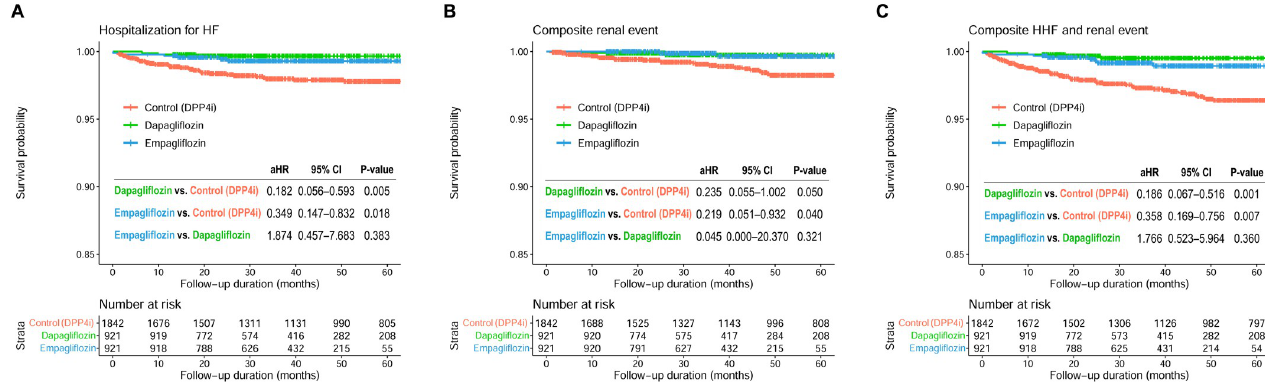
Fig 3. Event-free survival curves for HHF and renal events. Kaplan-Meier curves comparing the risk of (A) HHF, (B) composite renal events, and (C) composite HHF and renal events between the 3 groups. CI, confidence interval; HHF, hospitalization for heart failure; HR, hazard ratio; SGLT2i, sodium- glucose co-transporter 2 inhibitor.